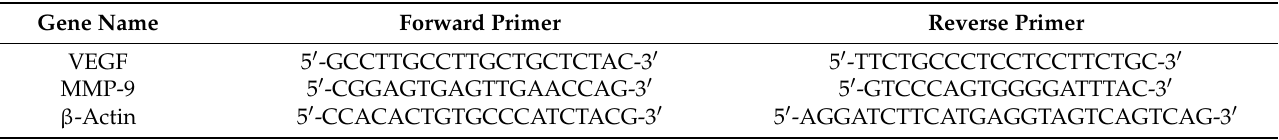
Table 1. Primer sequences used for quantitative RT-PCR